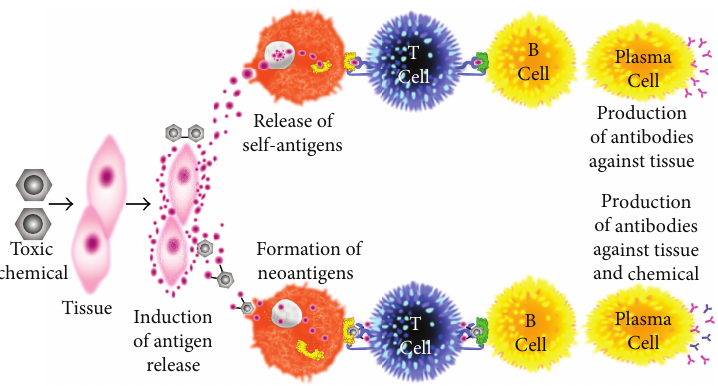
Figure 3: Putative mechanism of chemical-induced